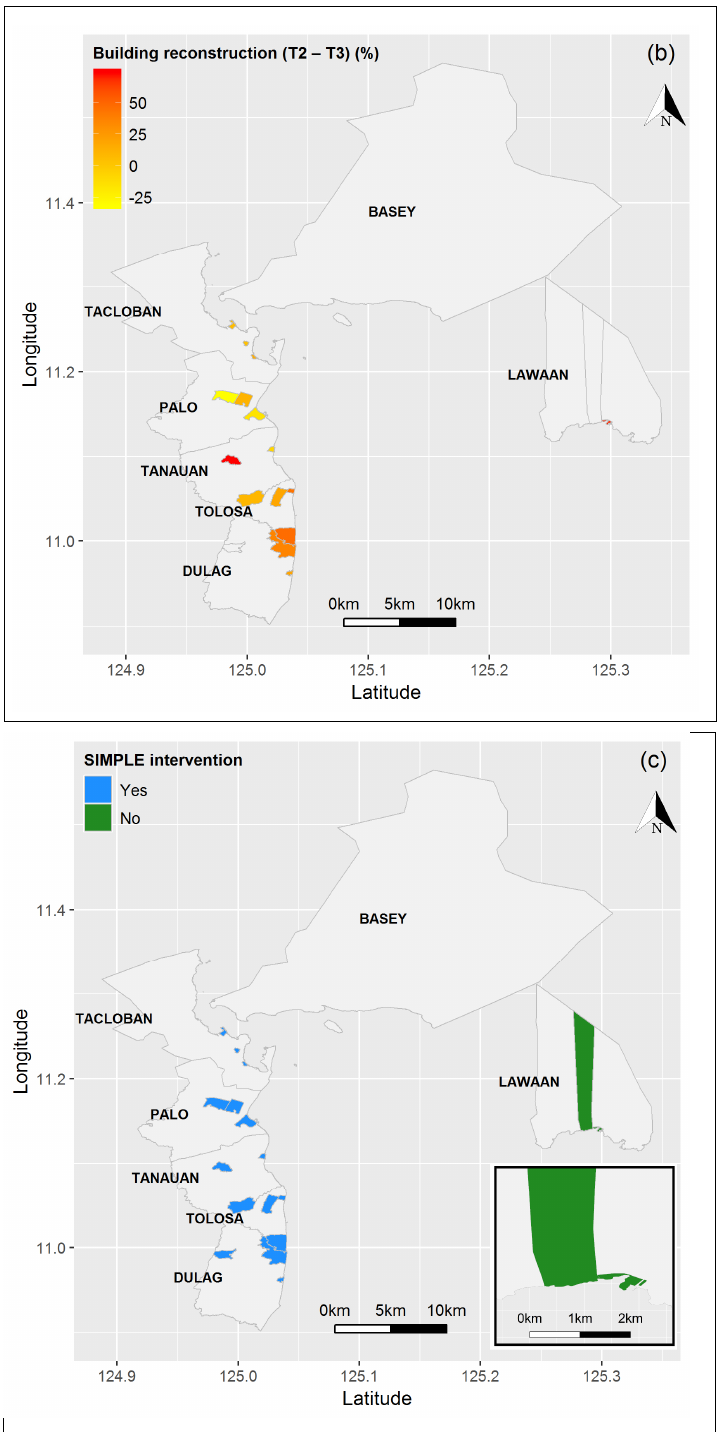
Figure 6. Building recovery during the early (a) and late recovery phase (b), as well as the Sustainable Integrated Management and Planning for Local Government Ecosystems (SIMPLE) intervention per barangay (c). Notes: T1–T2 = early recovery phase; T2–T3 = late recovery phase; we were unable to compute late building recovery rates (T2–T3) for Betaog (large center barangay in Lawaan) due to extensive cloud coverage at T3; Panel C: the inset shows from left to right the large barangay Betaog, and the considerably smaller barangays Poblacion 1, and Poblacion 4 within the Lawaan municipality. Structural characteristics. For structural characteristics, significant relationships emerged mainly for building reconstruction, while industry recovery was comparatively unaffected. We observed higher growth rates in urban vs. rural areas (b = 936.72, p < 0.05). Barangays that received IRA subsidies showed higher reconstruction rates (b = 112.85, p < 0.05) during the early phase, but negative reconstruction rates (b = –2.86, p < 0.05) during the late phase. Disaster risk management. Those barangays that had previously experienced a natural disaster showed slower industry recovery rates (b = –75.39, p < 0.05) than those without such experiences. Moreover, our analysis revealed that reconstruction support was significantly related to a lower building reconstruction rate in the later phase (b = –50.02, p < 0.001). Local governance. Good governance may facilitate the recovery process through administrative